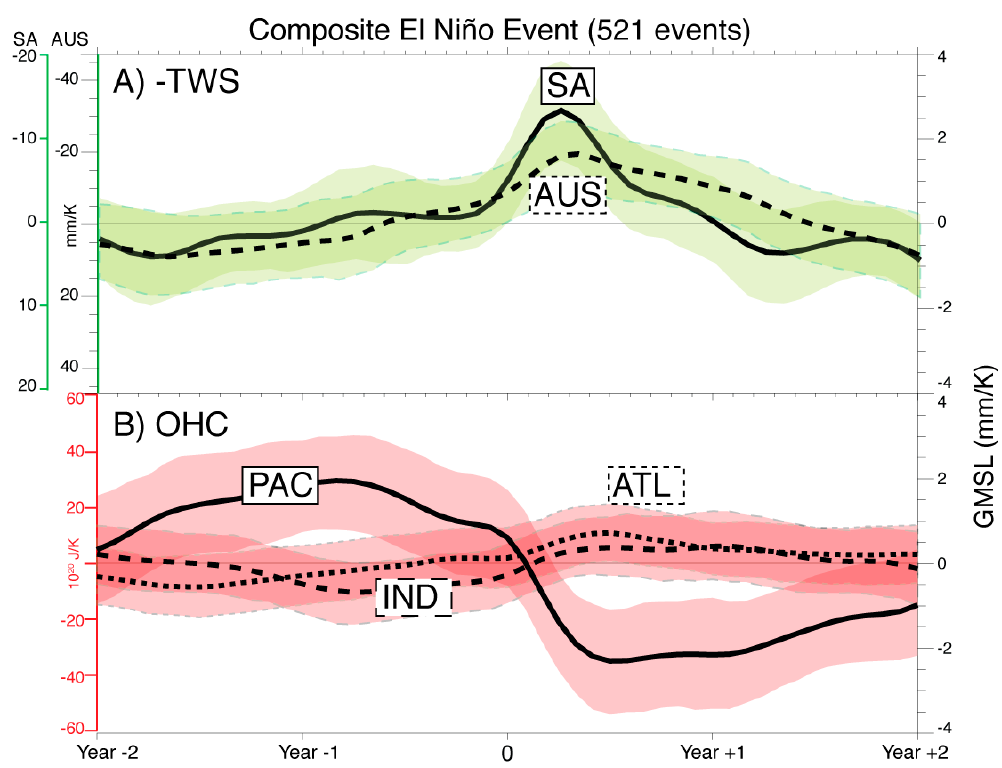
Figure 5. Contribution of key: ( A ) continental (TWS); and ( B ) ocean basin (OHC) contributions to the GMSL budget during El Niño. Shading indicates the σ range across ensemble members.